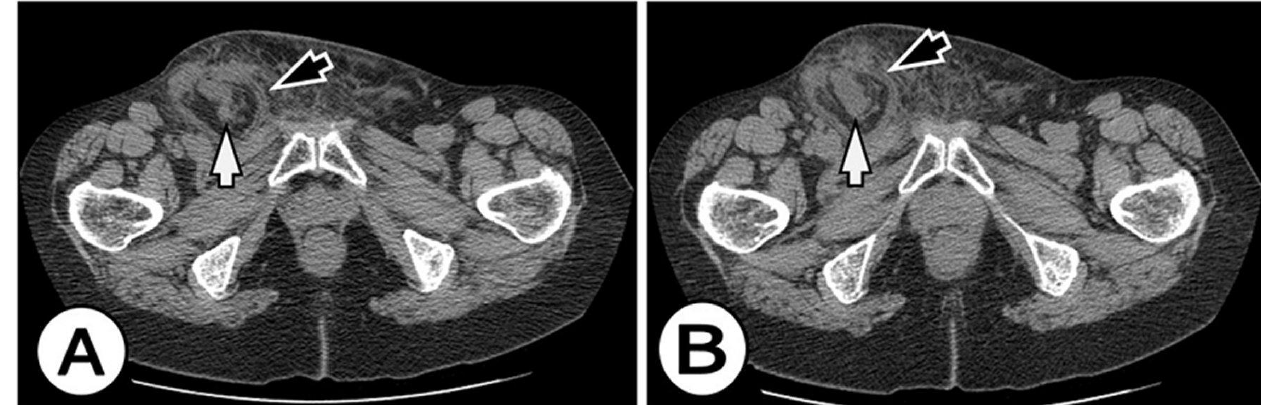
Figure 1: Axial CT scan at the level of inguinal regions shows an inflamed appendix (white arrow) extends into the small right inguinal hernia (black arrow). There were no signs of obstruction or